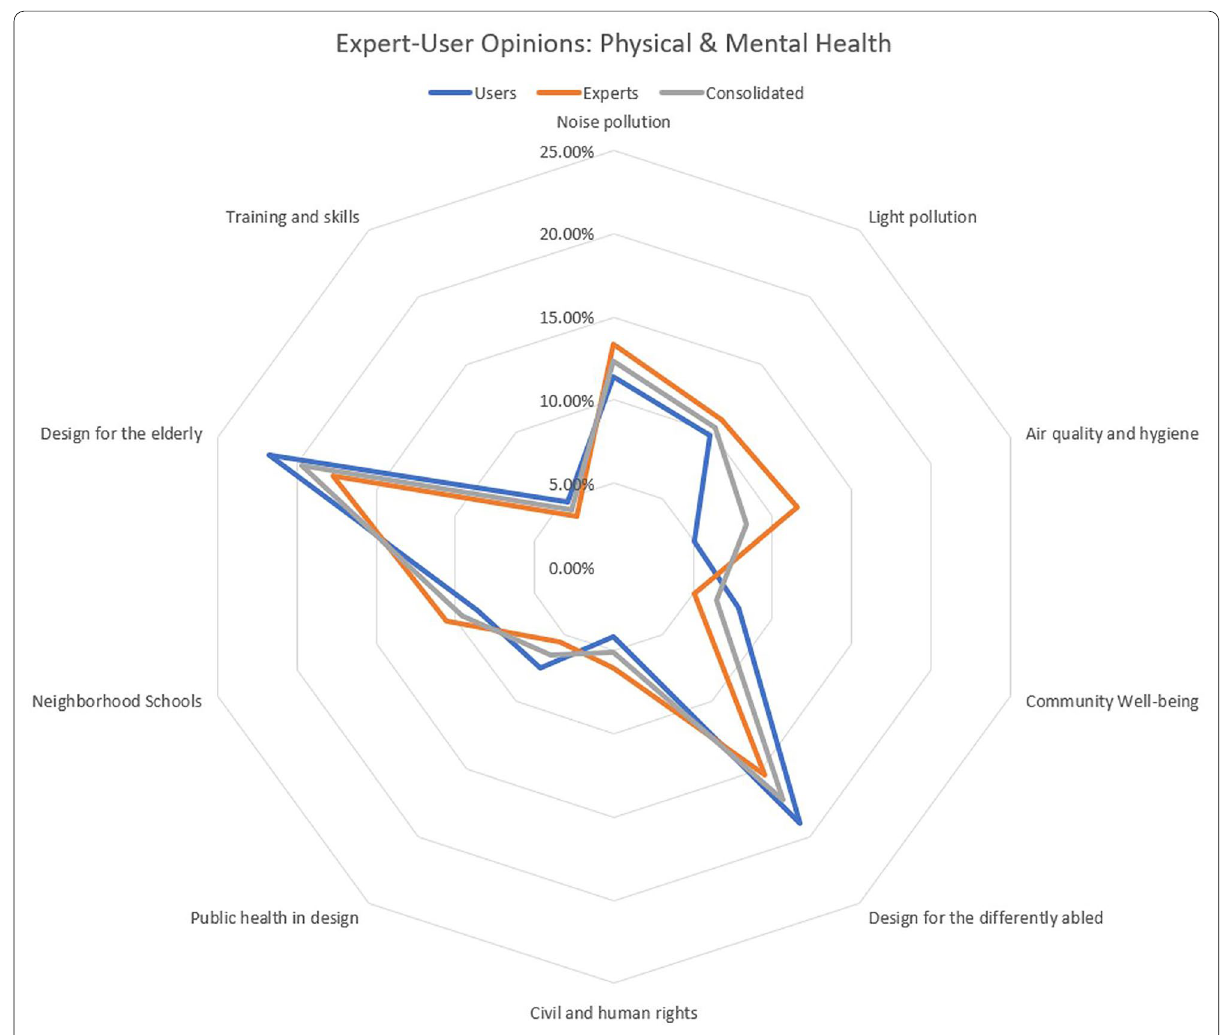
Fig. 7 Comparison between experts and users’ opinions—physical and mental